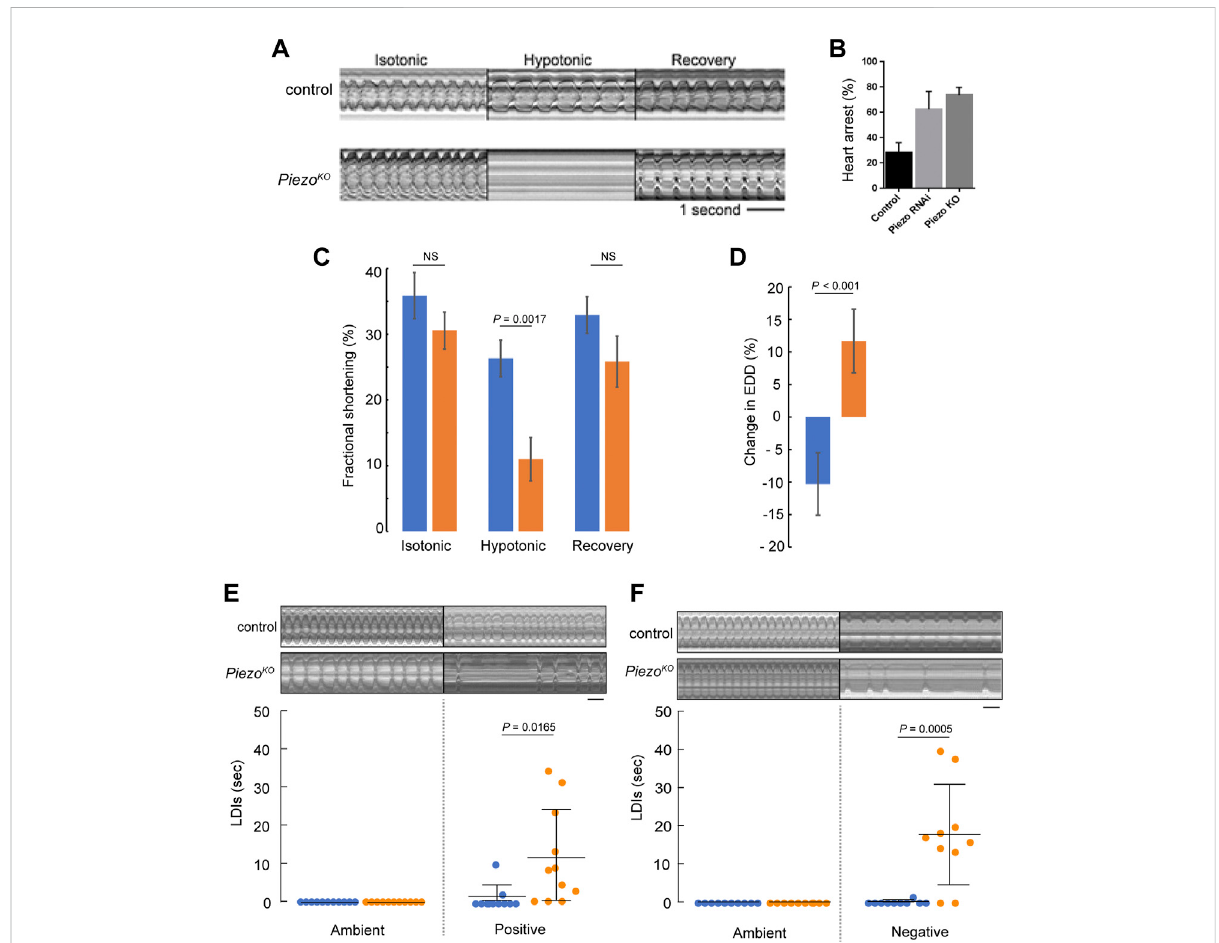
FIGURE 2 Piezo hearts fail to buffer mechanical stress. (A) M-mode kymograph traces for control (upper) and Piezo KO (lower) adult hearts in isotonic, hypotonic and isotonic (recovery) solutions. (B) Percentage of cardiac arrest during hypotonic stretch in control, Piezo-RNAi and Piezo KO animals. ( n = 28, 23, and 24). (C) Fractional shortening in the conical chamber under isotonic (left), hypotonic (middle) and isotonic (recovery) conditions for control (blue, n = 12) and Piezo KO (orange, n = 12) hearts. There is no statistical difference in FS for control hearts in isotonic versus hypotonic solution ( p = 0.19, n = 12, one-way ANOVA) (D) Response of the hearts to hypotonic stress. Percentage change in end diastolic diameter (EDD) for control (blue)and Piezo KO (orange)heartsmeasuredattheconicalchamber( n =10and10). (E) Graphshows quanti fi cationoflongdiastolicintervals (LDIs) for control (blue, n = 11) and Piezo KO (orange, n = 11) hearts under conditions of ambient and positive (+220 mmHg) pressure. Each data point represents an individual heart preparation; the y -axis shows additive time in LDI over a 60 s period for each individual preparation. Typical M-mode kymograph trace for control and Piezo KO adult hearts are shown (upper panel). (F) Graph shows quanti fi cation of LDIs for control (blue, n = 10) and Piezo KO (orange, n = 10) hearts under conditions of ambient and negative ( − 482 mmHg) pressure. Each data point represents an individual heart preparation; the y -axis shows additive time in LDI over a 60 s period for each individual preparation. Typical M-mode kymograph trace for control and Piezo KO adult hearts are shown (upper panel). p -values, unpaired t-test. NS = not signi fi cant. Scale bar in A, E, F = 1